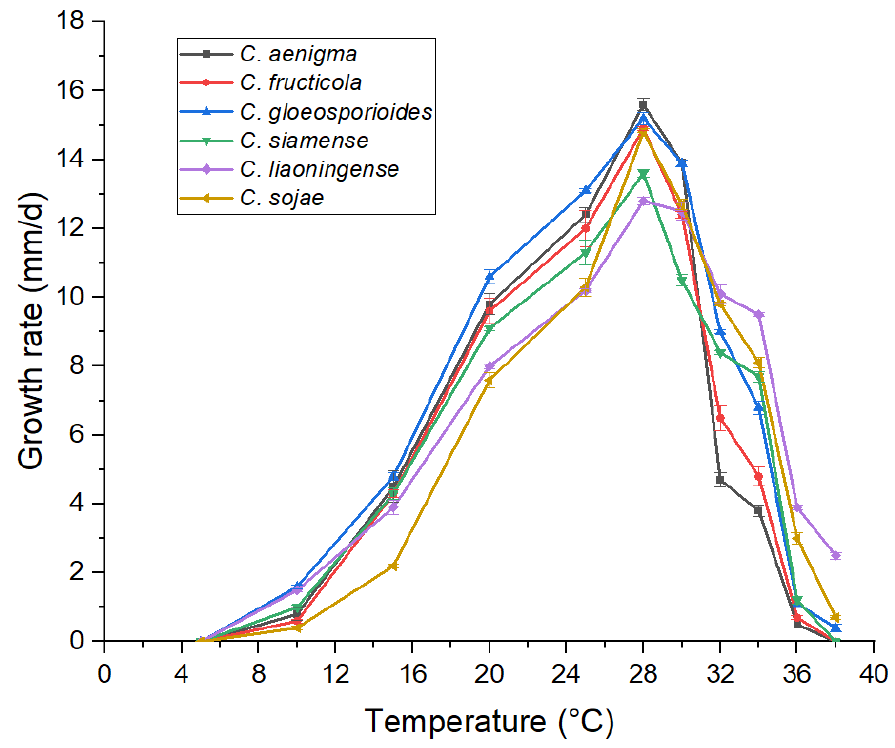
Figure 6. Colony growth rate of walnut anthracnose under different temperatures for four days. Different strains could stand various temperatures. Results showed C. gloeosporioides , C. liaoningense and C. sojae could grow at up to 38 ◦ C. At 38 ◦ C, C. liaoningense showed the strongest temperature resistance with an average growth rate of 2.5 mm/d, followed by C. sojae and C. gloeosporioides at 0.7 and 0.43 mm/d. C. aenigma , C. fructicola and C. siamense showed poorer resistance to high temperature; mycelial growth was not observed at 36 ◦